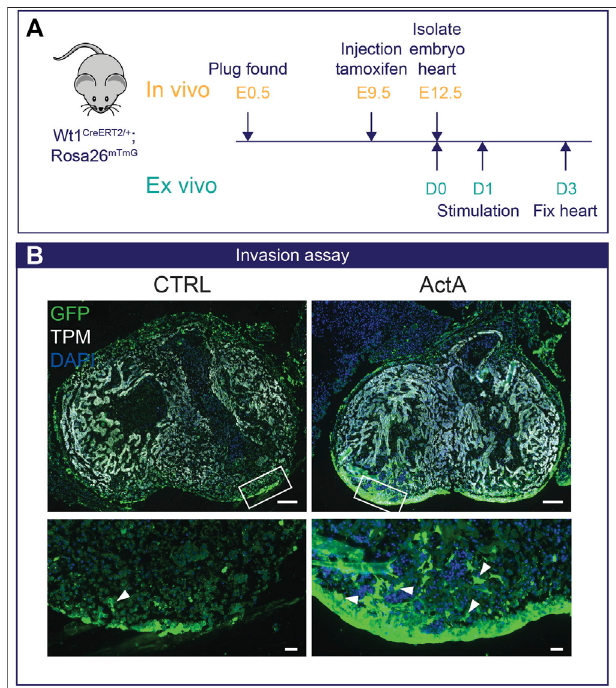
FIGURE5| ActivinAsignalinginitiatesepicardialinvasioninmouseheart (A) Experimental design: Pregnant dams are injected with tamoxifen at E9.5 and embryos are isolated on E12.5. Wt1 creERT2/+ ;Rosa26 mTmG /+ embryos were cultured ex vivo for 24 h and then stimulated with either 200 ng/ml ActivinA( n (cid:1) 3)orcontrolmediumfor48 h. (B) Immuno fl uorescentstainingfor GFP (green), tropomyosin (TPM, white), and DAPI (blue). White arrows indicate Wt1-Cre-GFP+ epicardial cells that have invaded the myocardium. Scale bar: 100 µm for overview and 20 µm for